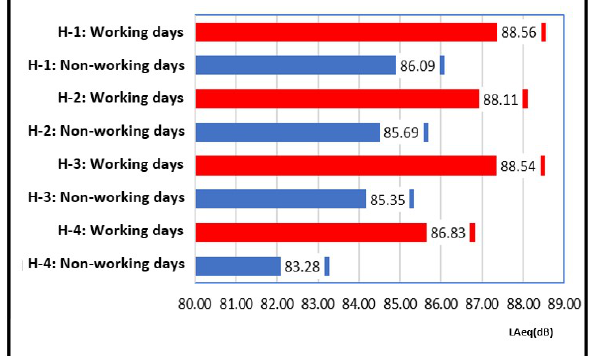
Figure 4: Behaviour of the average LAeq (dB) values according to working and non-working days at the four hospitals